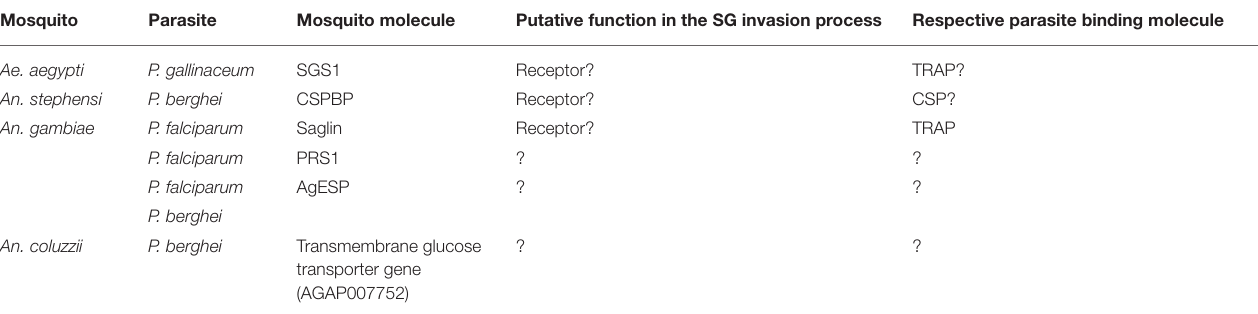
TABLE 4 | Putative factors promoting mosquito salivary gland invasion by Plasmodium parasites. Mosquito Parasite Mosquito molecule Putative function in the SG invasion process Respective parasite binding molecule